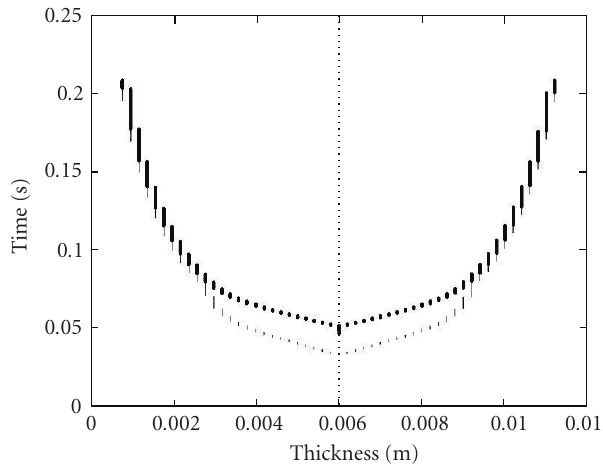
Figure 4.6. Example 1: extent of mushy and molten regions as a function of time for R g = 10 − 9 initially without voltage shut-o ff . Darker markers indicate molten zone; lighter markers indicate mushy